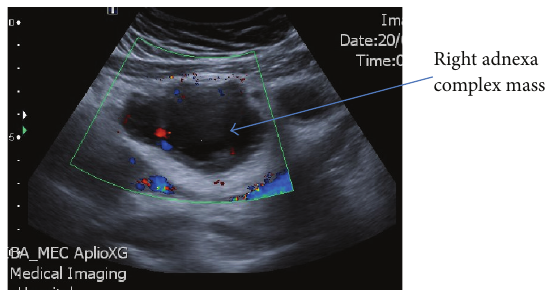
Figure 2: Transabdominal ultrasound of right adnexa-complex mass noted 70 mm × 45 mm × 42 mm.